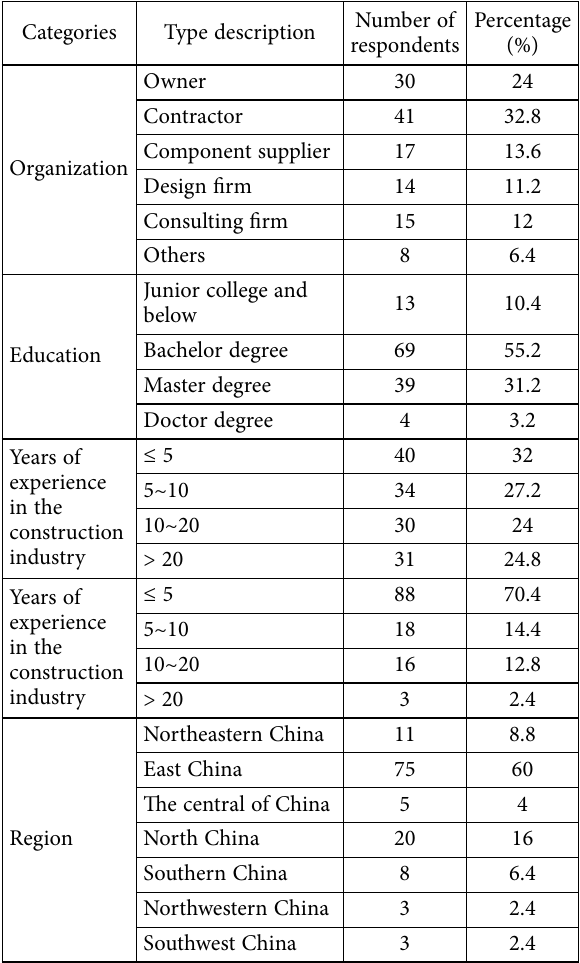
Table 2. Demographic information of